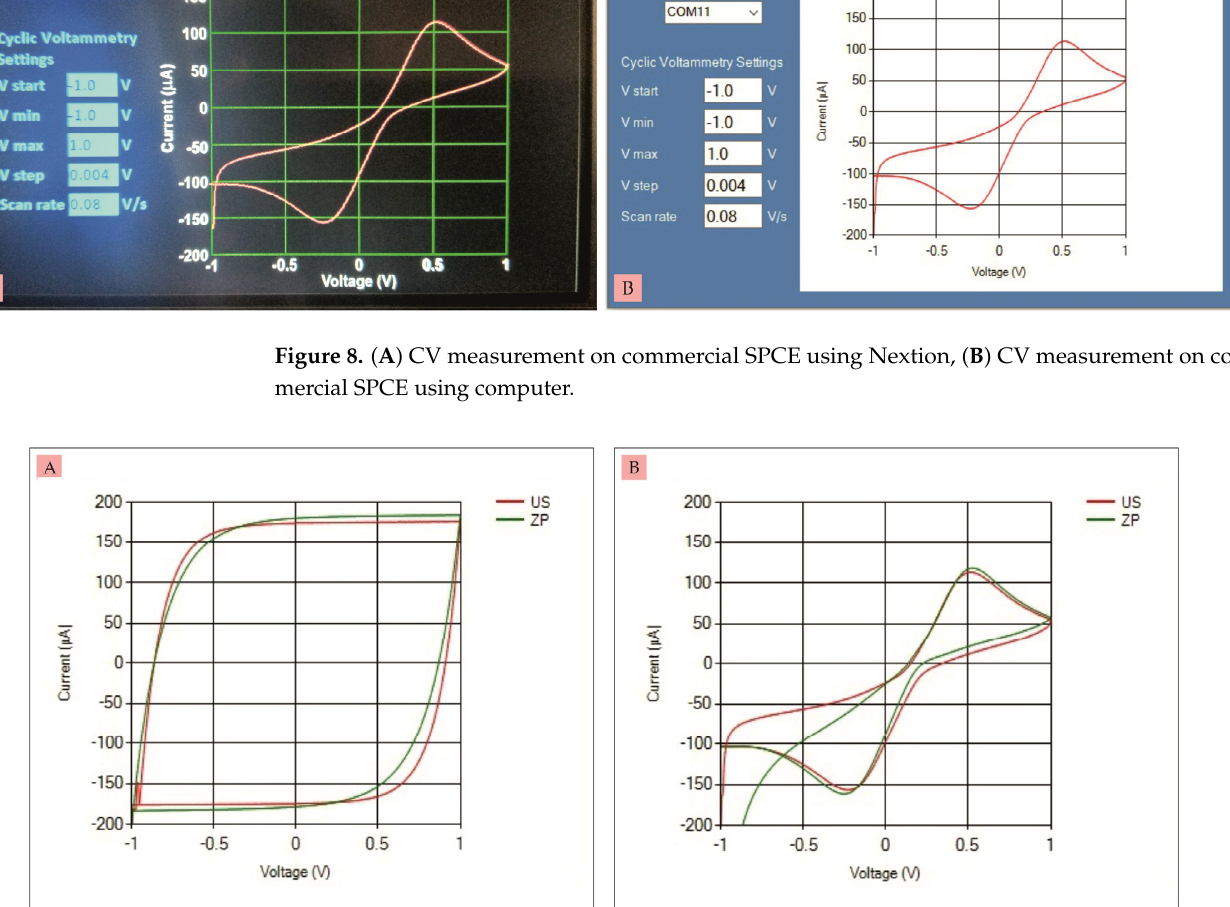
Figure 8. ( A ) CV measurement on commercial SPCE using Nextion, ( B ) CV measurement on com- mercial SPCE using computer.